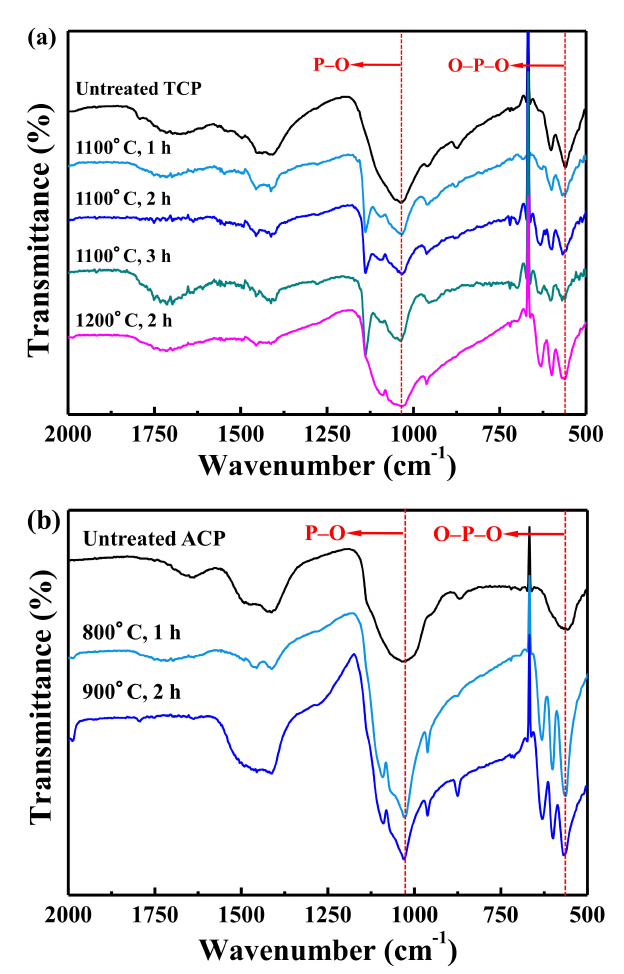
Figure 2. FTIR spectra of ( a ) sintered TCP and ( b ) sintered ACP powder. The results from ( a ) show that TCP can be generated stably at a temperature of 1300 ◦ C. The results from ( b ) indicate that the structure of ACP was converted into TCP after heat treatment. The x -axis of the spectra is the frequency of infrared light, or wave numbers, measured in reciprocal centimeters (cm − 1 ); the y -axis is the infrared light